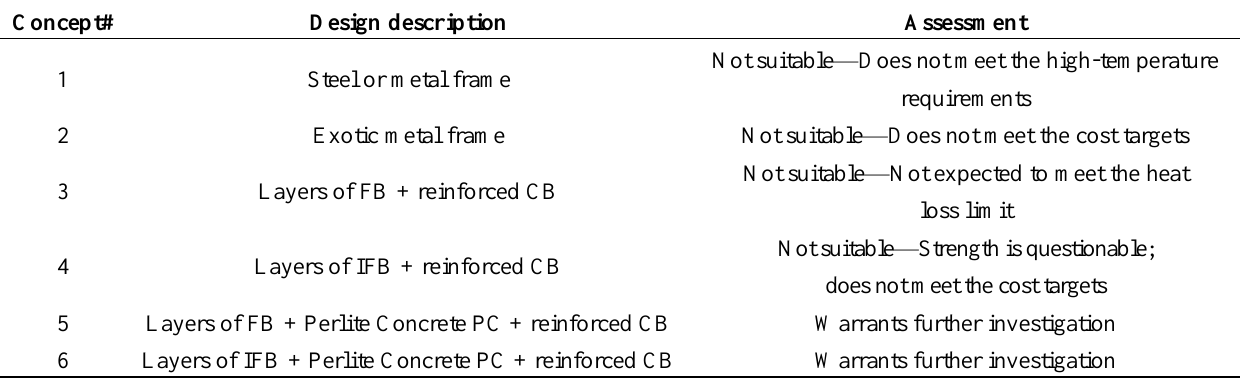
Table 1. Hot-bin material design concepts. FB: firebrick; CB: concrete brick; IFB: insulating firebrick; PC: perlite concrete.